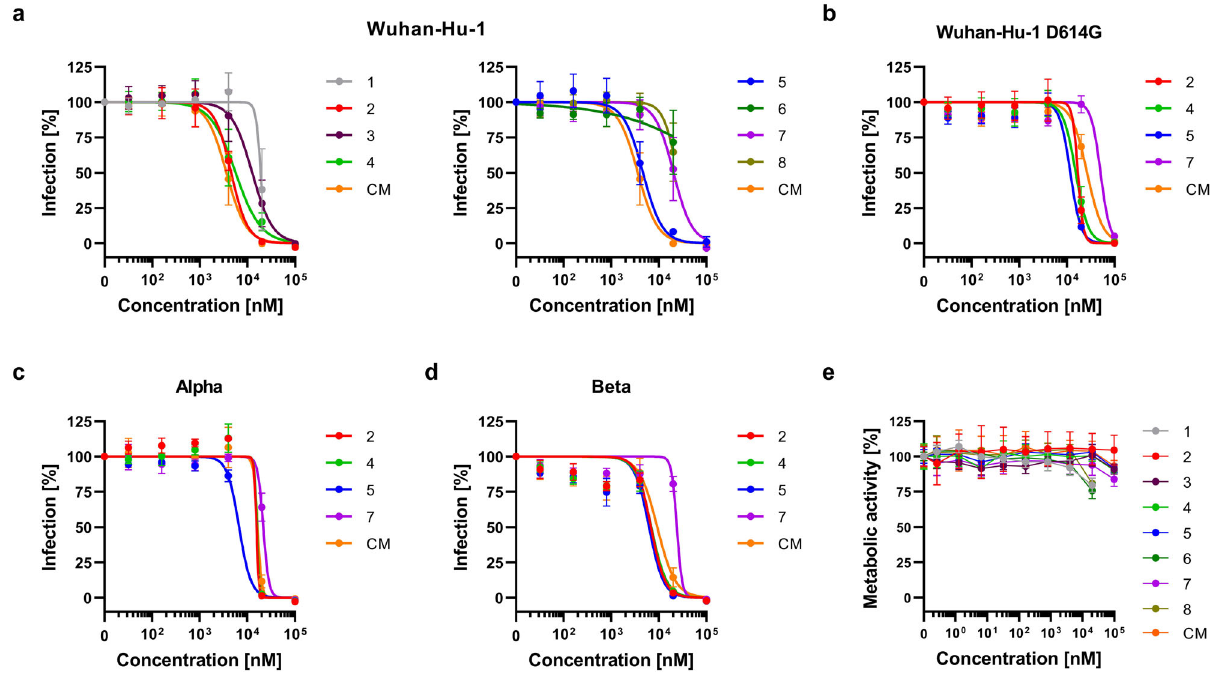
Fig. 6 Peptidomimetic inhibitors reduce SARS-CoV-2 infection. Peptidomimetic inhibitors and the small molecule camostat mesylate (CM) were added to Caco-2 cells. After 1 h, cells were infected with SARS-CoV-2 Wuhan-Hu-1 ( a ), SARS-CoV-2 bearing the spike D614G mutation ( b ), or the variants of concern Alpha ( c ) and Beta ( d ). Infection rates were determined 2 days post infection by in cell ELISA for the viral N protein. ( e ) Cytotoxicity of peptidomimetic inhibitors. Inhibitors and the small molecule camostat mesylate (CM) were added to Caco-2 cells. Cell viability was assessed 2 days post addition by measuring ATP content in cell lysates. Due to low stock concentration compounds 1, 6, and 8 were tested at a maximum concentration of 20,000nM. Shown are the means± SEM of n = 3 independent experiments ( a – d ) or mean ± SD of n = 1 experiment ( e ), each performed in triplicates. Calculated IC 50 values for each compound are listed in Supplementary Table 8.